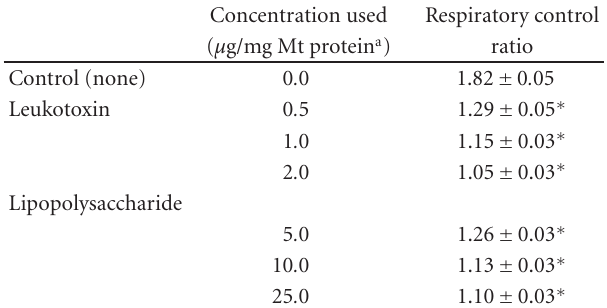
Table 3: E ff ects of leukotoxin and lipopolysaccharide on the respiratory control ratio (RCR) in mitochondrial fractions from rat gingival